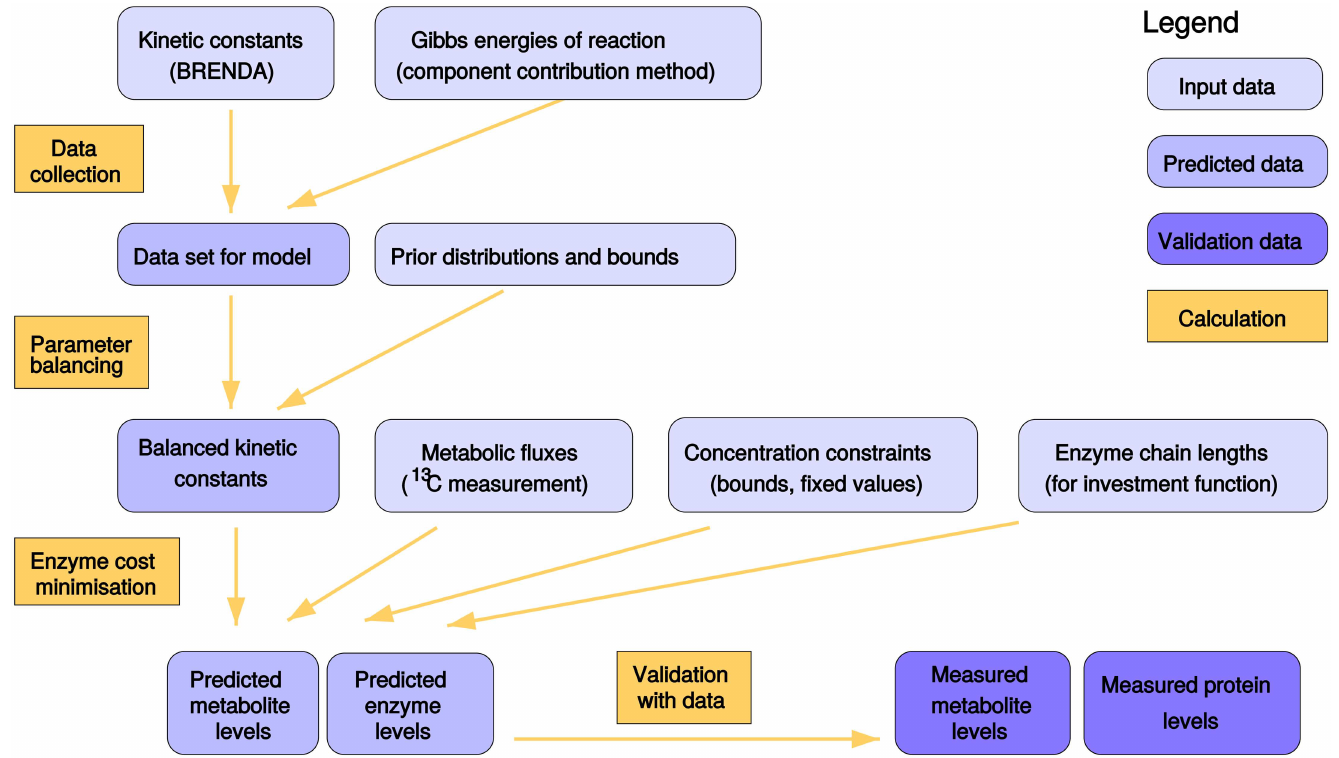
Fig 8. Data integration in the ECM-based modeling workflow. After collectingall available kinetic and thermodynamic data and mapping them onto the network model, we use parameter balancingto obtain a consistent, complete set of kinetic constants. For a fully parameterized kinetic model, the metabolite and enzyme levels must be determined. We compute them by enzyme cost minimizationwith predefined metabolic fluxes (obtainedfrom experiments or computationally). Finally, the predicted values are validatedwith measuredmetabolite and protein